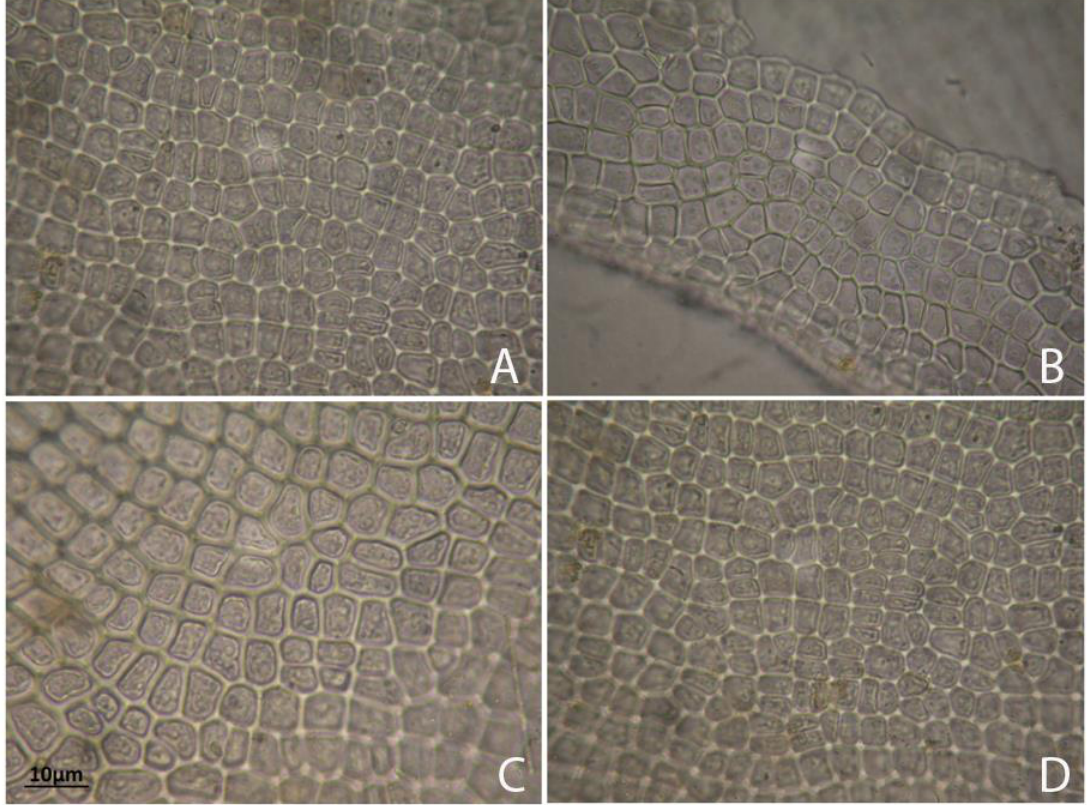
Figure 4. Ulva pilifera ( A , D ) close-up view on the slightly rounded and/or polygonal vegetative cells well-ordered in long rows in the mid region of the thallus with parietal chloroplast and 2–3 pyrenoids; ( B ) rectangular cells in a branch showing parietal chloroplasts covering the majority of the cell walls; ( C ) irregularly arranged vegetative cells in the thallus with 2–3 pyrenoids. Scale bars: 10 µm.